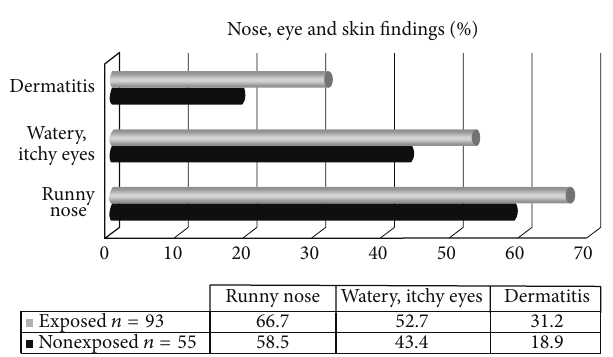
Figure 2: Nose, eye, and skin complaints among tear gas exposers. Table 3: Pulmonary functions of subjects.